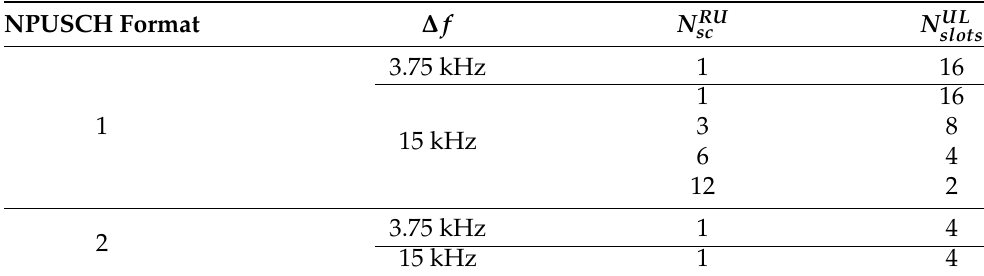
Table 4. NPUSCH parameters [2].